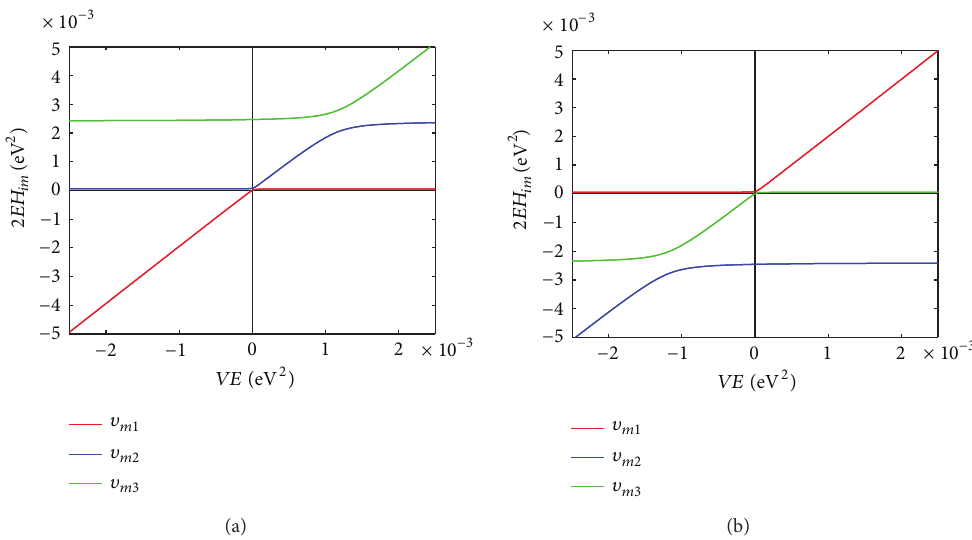
Figure 3: The energy level scheme. We here show the dependence of the eigenvalues of the Hamiltonian in matter on 𝐸𝑉 . Note that we are plotting 2𝐸𝐻 𝑖𝑚 , which goes to Δ𝑚 2 𝑖1 for low 𝑉𝐸 . The left (right) panel corresponds to normal (inverted) mass ordering.